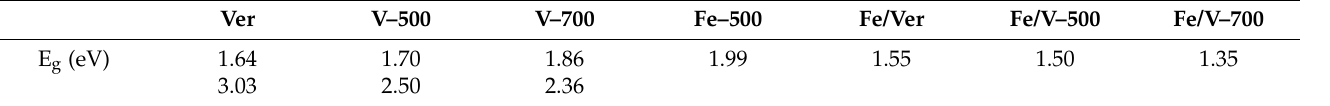
Table 5. The band-gap energies E g of vermiculite samples, α -Fe 2 O 3 nanoparticles and α -Fe 2 O 3 nanoparticles/vermiculite composite samples.